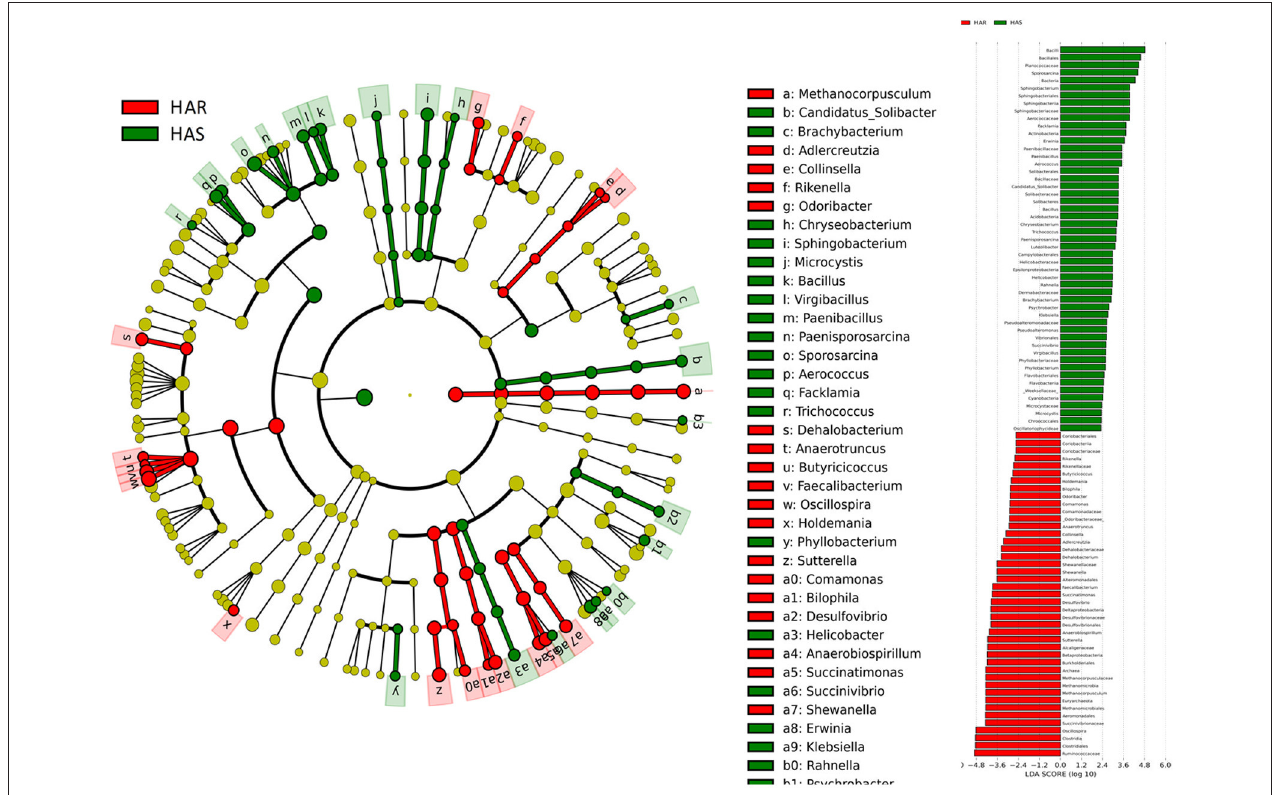
FIGURE 5 | LEfSe identified taxons for HAS and HAR. (Left) Taxonomic cladogram. Taxa enriched in HAR or HAS are colored by red or green, respectively. (Right) HAS-enriched taxa are shown with a positive LDA score (green), and taxa enriched in HAR are shown with a negative score (red). Only taxa meeting an LDA significant threshold > 2 and p < 0.05 are